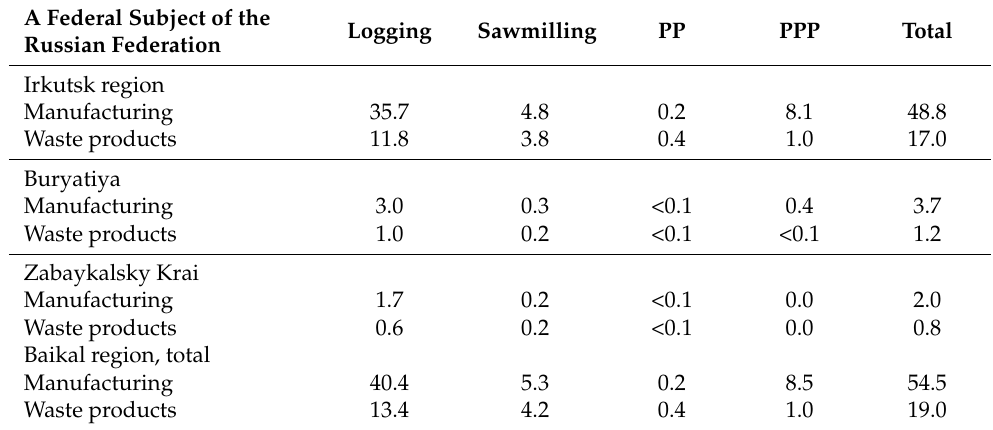
Table 4. Estimate of wood waste volumes in the Baikal region, million m 3